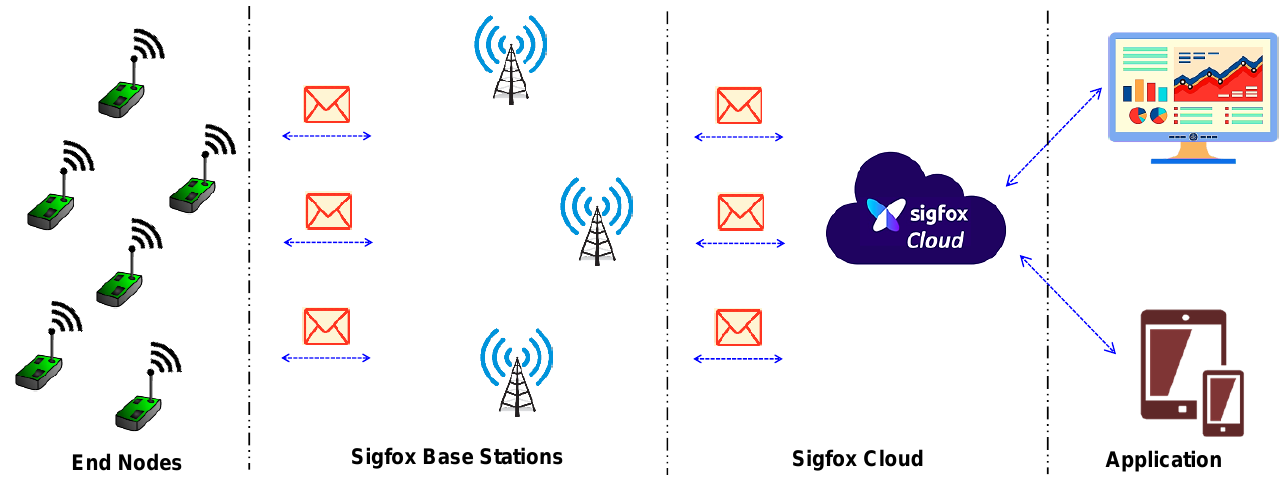
Figure 11. Sigfox network architecture.